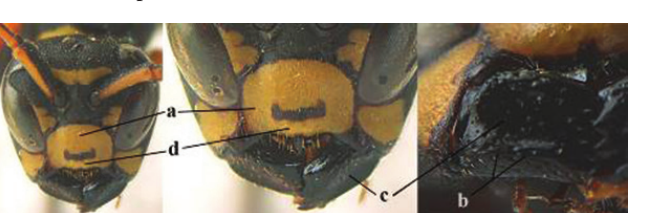
Clypeus 0.7 times as long as wide (a); lower ridge of mandible 0.4 times as wide as mandible (b); depression of mandible with rather dull surface (c); area above lower edge of clypeus (below dark spot) dull and straight (d); S and southern C Europe to W Asia ..... P. atrimandibularis Zimmermann, 1930